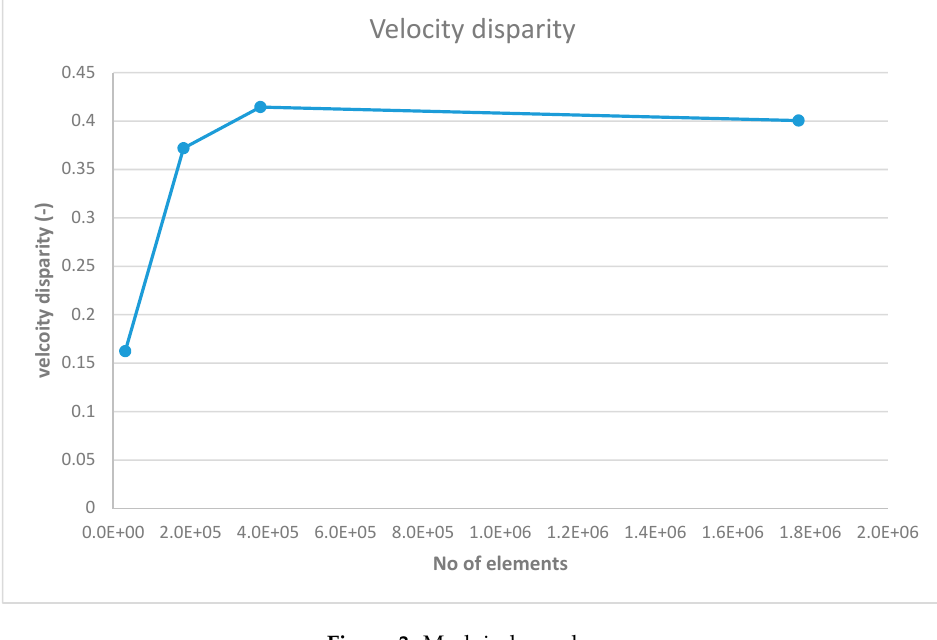
Figure 3. Mesh independency.